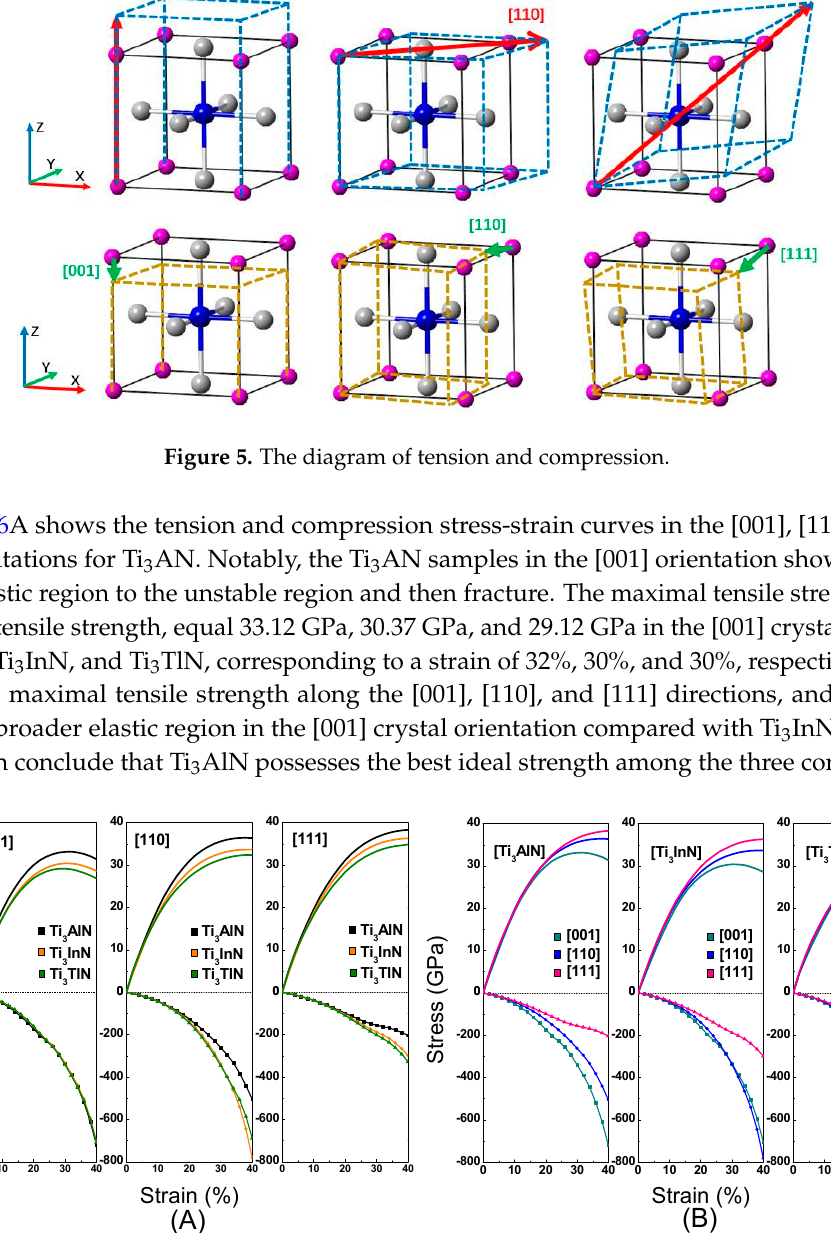
Figure 6. Stress-strain curves of tension and compression. ( A ) The tension and compression stress- strain curves in the [001], [110], and [111] crystal orientations for Ti 3 AN; ( B ) The anisotropy in the stress-strain variation of Ti 3 AN in different crystal orientations. (The smooth lines represent the tension and the lines with symbols represent the compression and the minus sign represents the magnitude of the compressive stress).